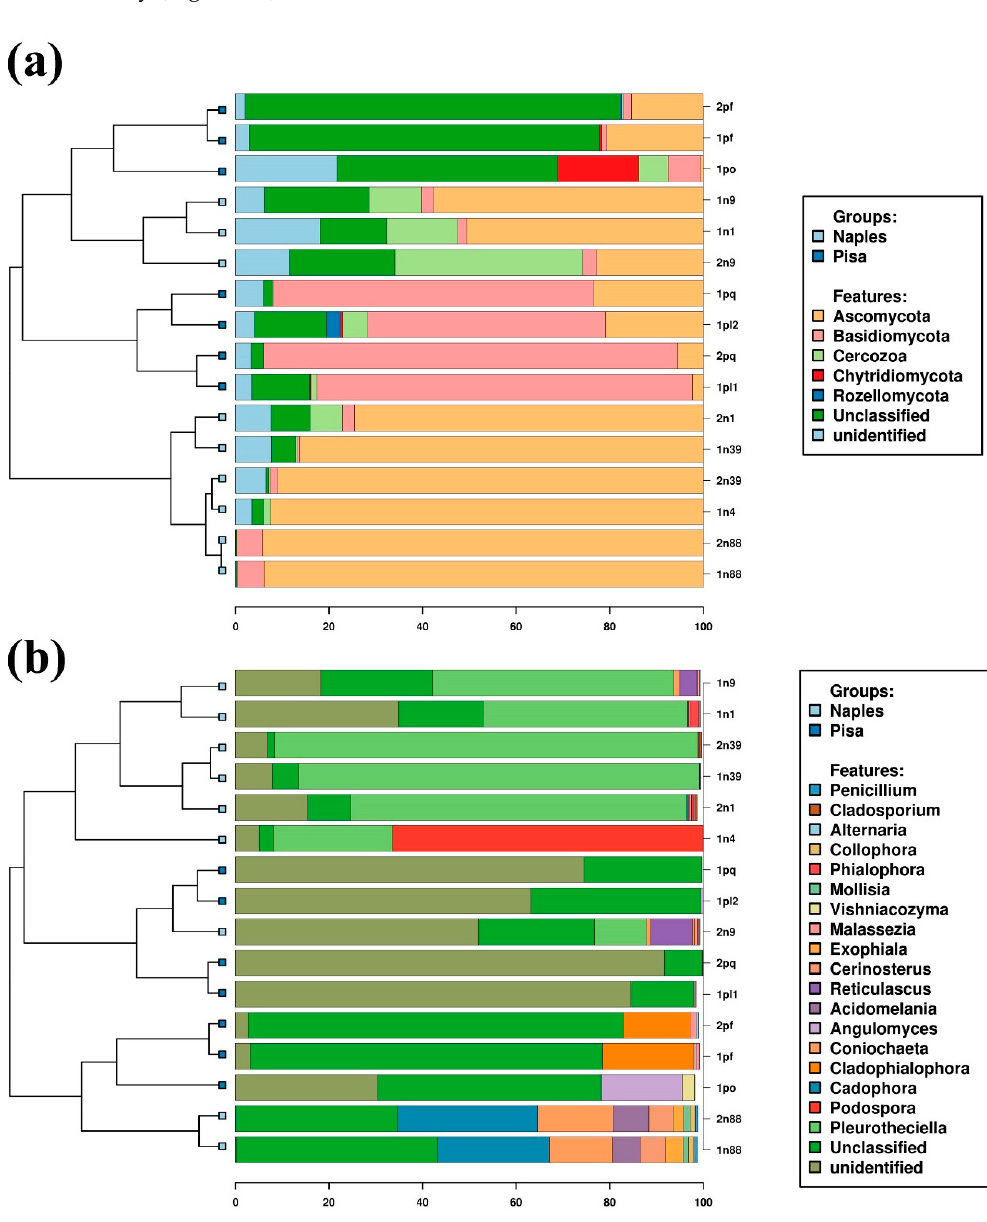
Figure 5. ITS2. Stacked barcharts of the taxonomic profile at phylum ( a ) and genus ( b ) Figure 5. ITS2 . Stacked barcharts of the taxonomic profile at phylum ( a ) and genus ( b ) level.